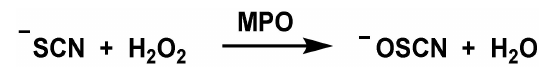
Figure 7. Catalyzed conversion of H 2 O 2 and SCN − to OSCN −